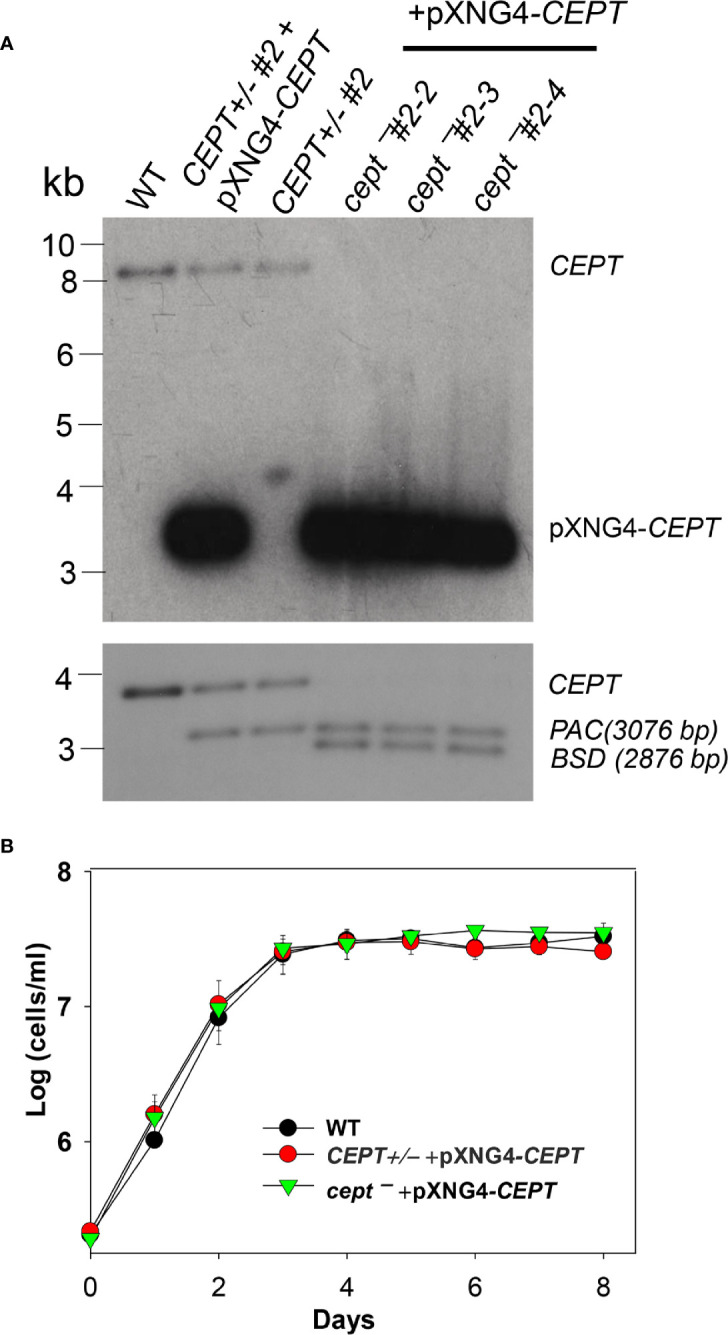
Deletion of L. major CEPT in the presence of pXNG4-CEPT. (A) Genomic DNA samples from WT, CEPT +/− clone #2, CEPT +/− +pXNG4-CEPT (clone #2), and cept¯ +pXNG4-CEPT (clones #2-3, 2-3, and 2-4) parasites were processed for Southern blot using radiolabeled probes for the ORF (top) or flanking sequence (bottom) of CEPT. Bands corresponding to chromosomal CEPT (top: 8252 bp, bottom: 3730 bp), pXNG4-CEPT (top: 3475 bp), PAC (bottom: 3076 bp) and BSD (bottom: 2876 bp) were indicated. (B) Promastigotes of WT, CEPT+/− +pXNG4-CEPT, and cept¯ +pXNG4-CEPT were cultivated at 27°C in complete M199 media and culture densities were determined using a hemocytometer. Error bars represent standard deviations from three experiments.